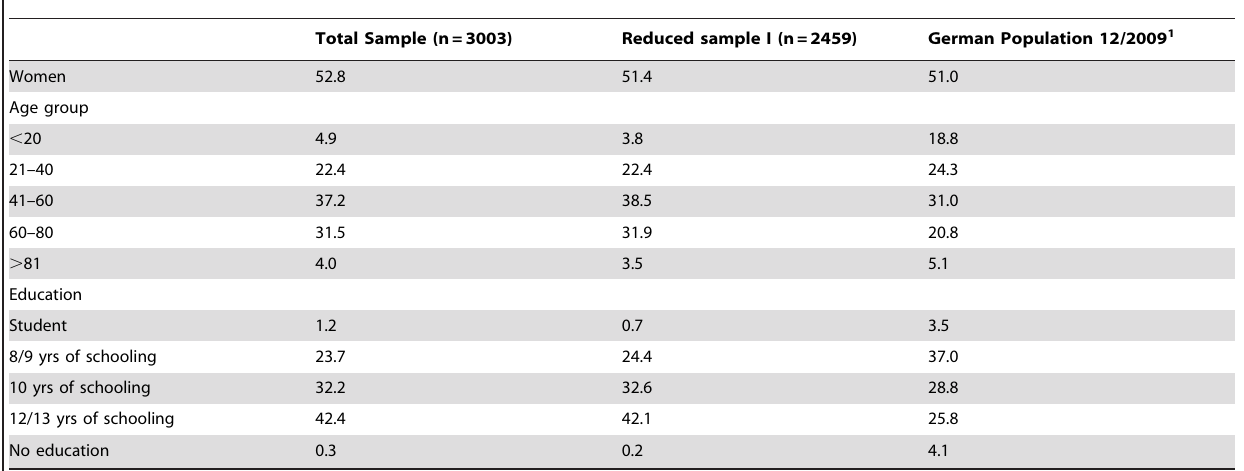
Table 1. Socio-demographic characteristics of the samples compared to the German general